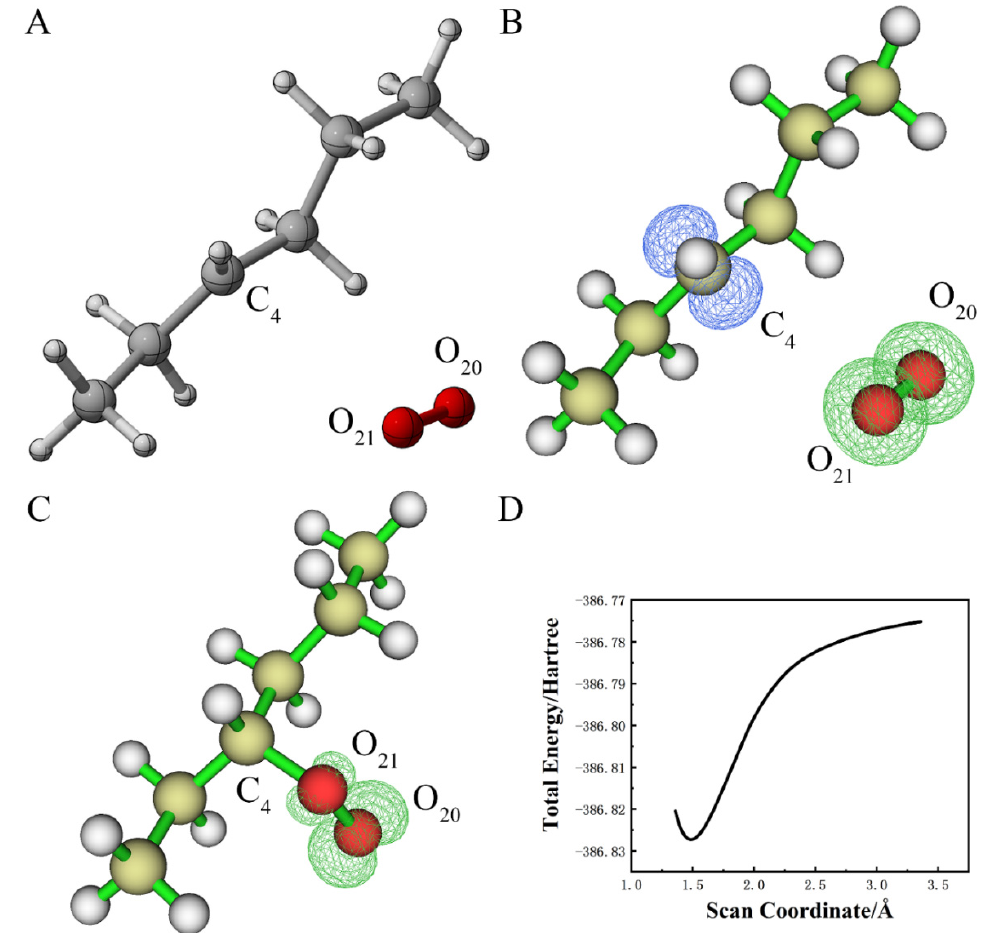
Figure 4. ( A ) The structure closest to the reactant of alkane radical with oxygen in the double state (when distance between O 21 and C 4 is the farthest during the relaxed scan); ( B ) the spin density of the structure in ( A ); ( C ) the spin density of the structure after the geometry optimization of the lowest energy point structure during the relaxed scan (this is a reflexive reaction with no transition state); ( D ) the result of the relaxed scan illustrates the change of the total energy along with the distance between O 21 and C 4 .